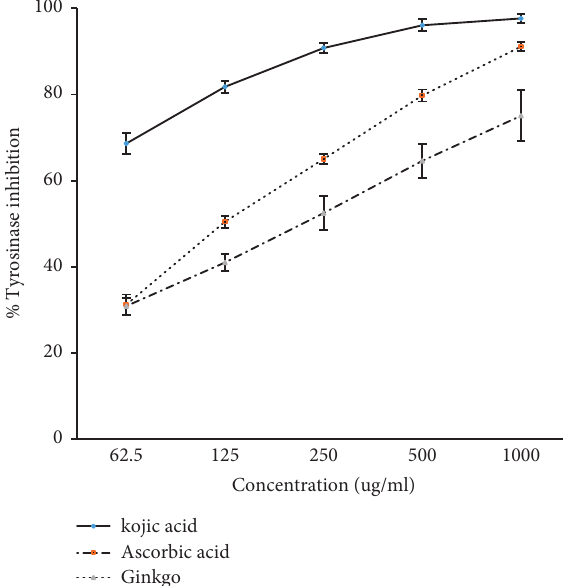
Figure 2: Tyrosinase inhibition of G. biloba tea extract with dif- ferent concentrations compared with that of positive controls kojic acid and ascorbic acid (mean ± SD, n � 3).